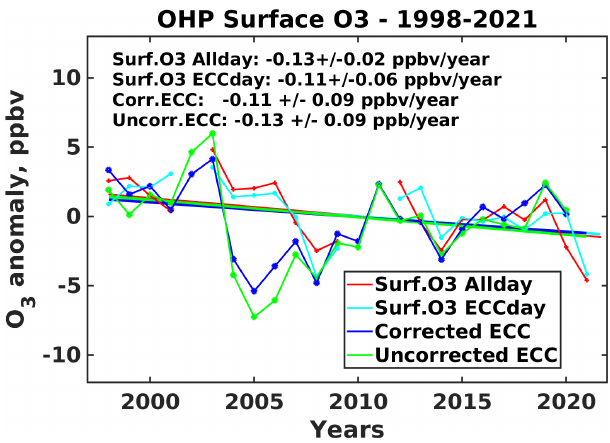
Figure 10. Interannual variation of deseasonalized O 3 mixing ra- tios (in ppbv) for the uncorrected ECC (green), homogenized ECC (blue) and daily mean observations of the OHP surface O 3 analyzer. The ECC mixing ratios are averaged in the 0.2km layer above the surface. The surface daily-mean observations are calculated when available (red) or for ECC launching days only (cyan). The cor- responding regression lines through all the O 3 anomalies between 1998 and 2021, O 3 trends (in ppbvyr − 1 ) and their uncertainties with a 95% confidence are also